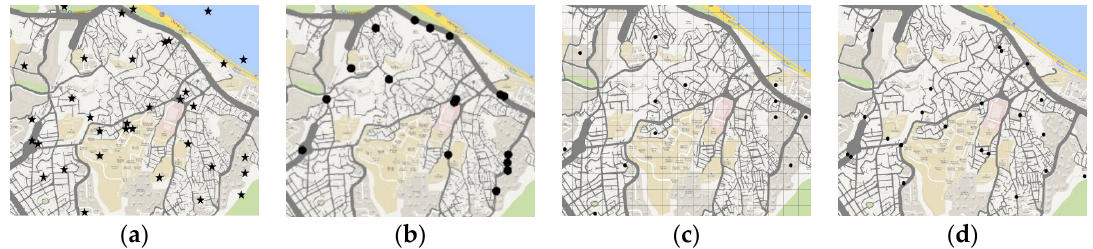
Figure 10. Random AED examples: ( a ) random AED allocation on road segments; ( b ) random AED allocation in study area; ( c ) random AED allocation on grid based; and ( d ) random AED allocation on network junctions.